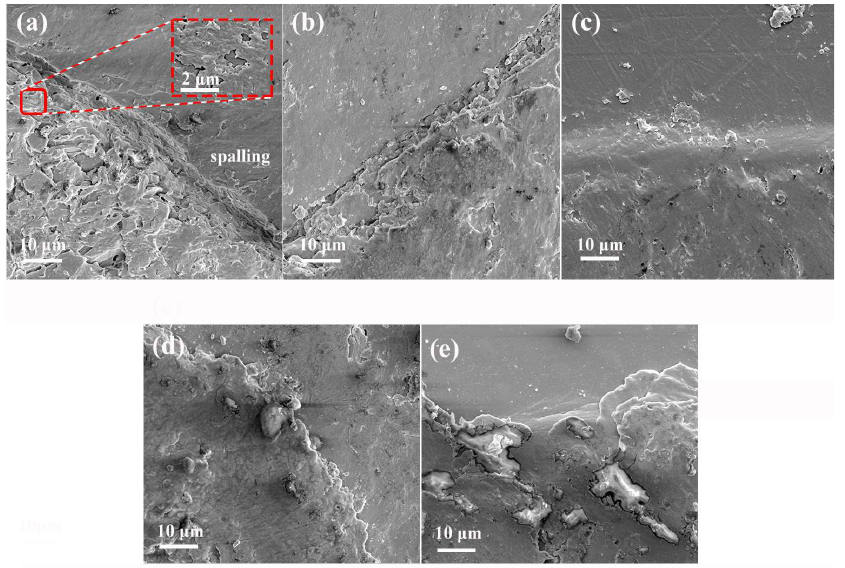
Figure 9. Surface SEM of the fractured coatings:( a ) EP, ( b ) 3-FEP, ( c ) 5-FEP, ( d ) 7-FEP, ( e )